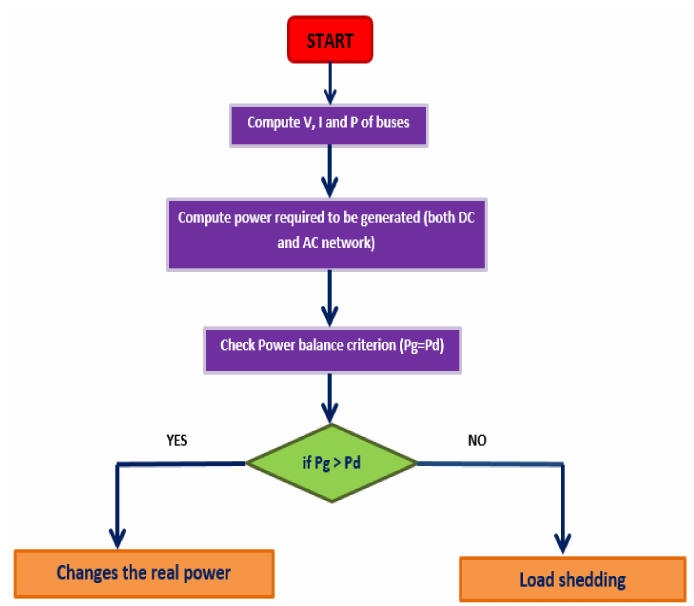
Figure 3. Power generation control